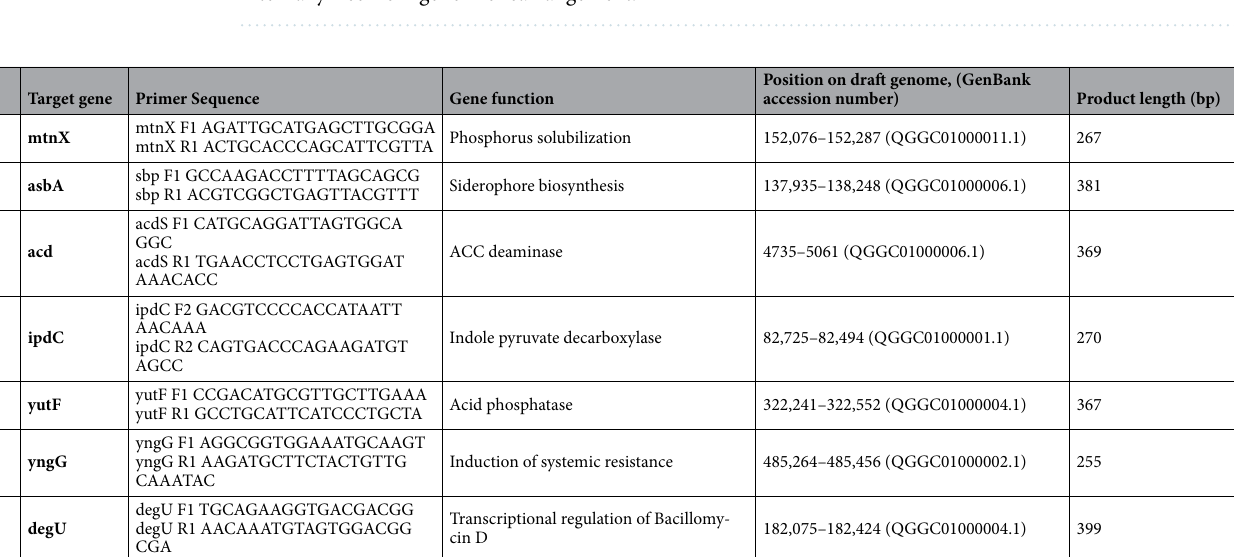
Figure 9. Comparison of genomes of Bar D5 in progressive MAUVE version 2.4.0 with Bacillus aryabhattai and Bacillus megaterium reference strains. Each genome panel contains the name of the genome sequence, a scale showing the sequence coordinates for that genome, and a single black horizontal centerline. Colored block outlines surround a region of the genome that aligned to part of another and is presumably homologous and internally free from genomic rearrangement.